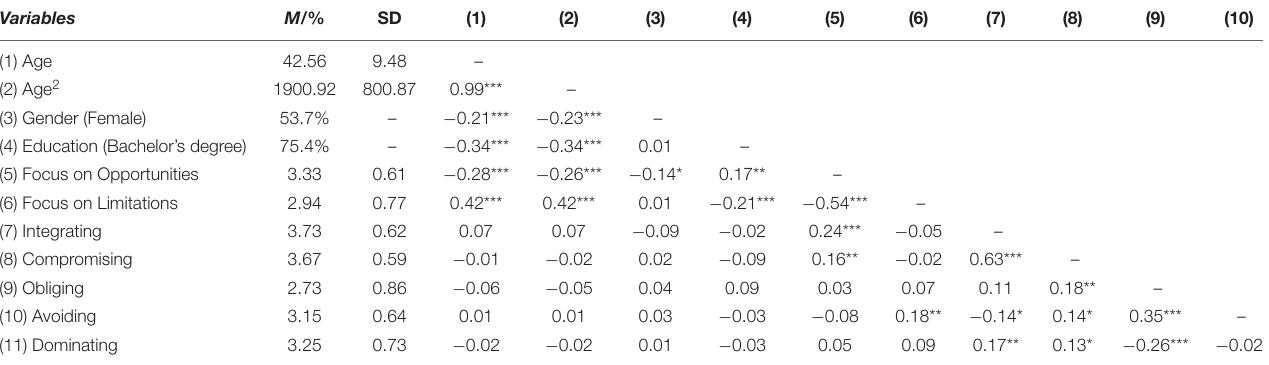
TABLE 2 | Descriptive statistics and correlation among major variables in Study 2 ( N =